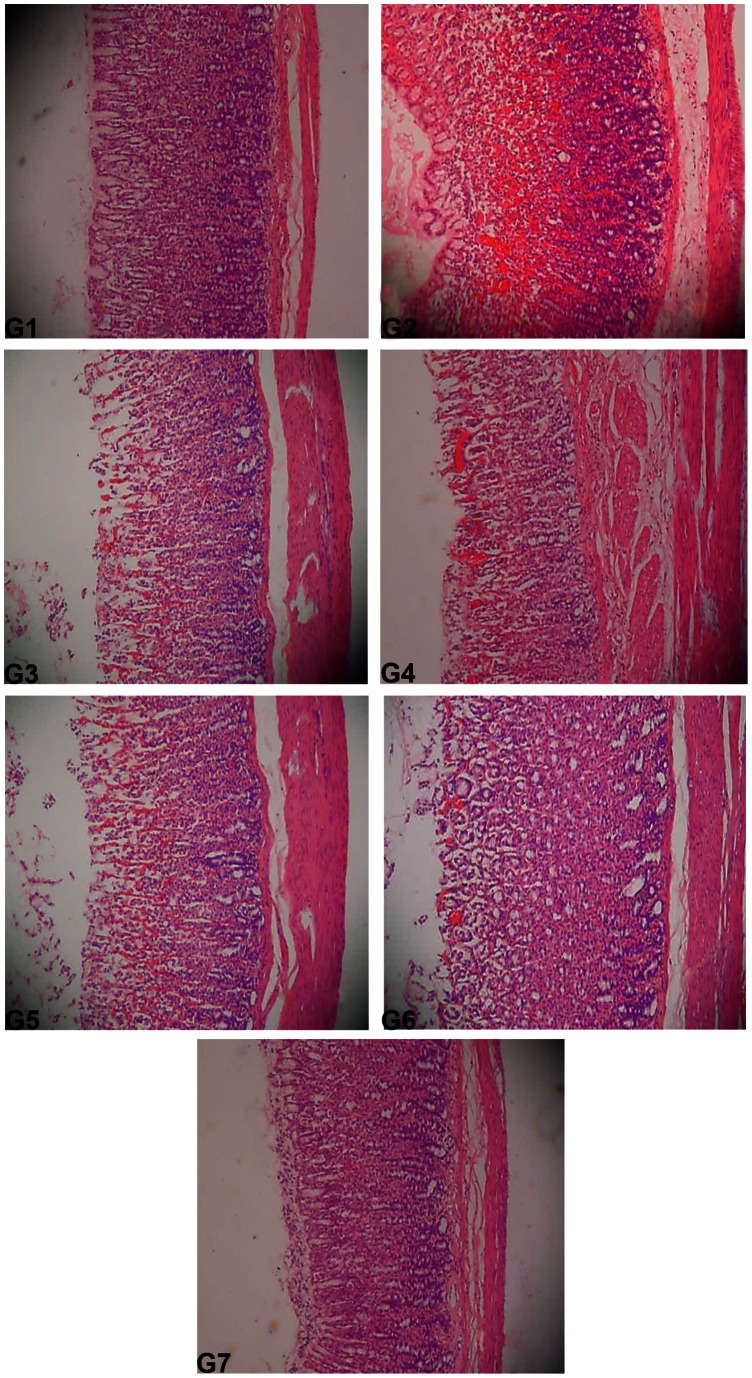
The effect of P. speciosa on the histology of ethanol-induced gastric mucosal damage in rats.(G1) (Normal control group); (G2) (Ulcer control group); (G3) (Omeprazole); (G4) (50 mg/kg), (G5) (100 mg/kg), (G6) (200 mg/kg), (G7) (400 mg/kg) Parkia speciosa extract. The rats in groups 4–7 demonstrated comparatively better protection of the gastric mucosa, as shown by a reduction in or absence of the ulcer area, submucosal edema and leucocyte infiltration (H&E staining, 20×).